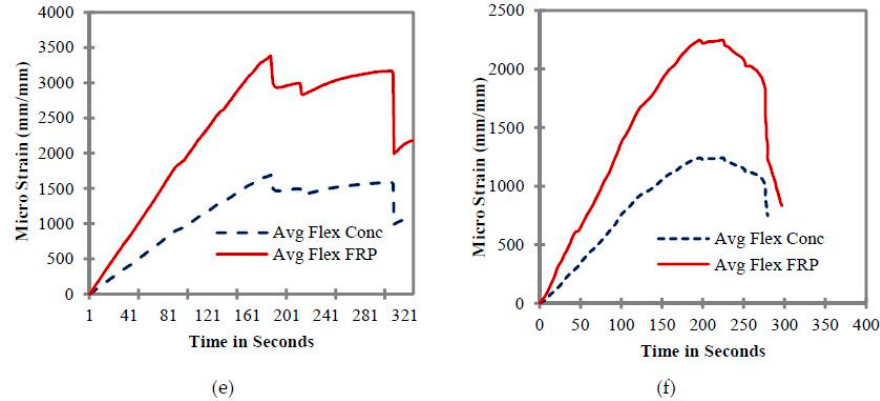
Figure 9. Comparison of concrete and CFRP flexural strain for ( a ) Control and B1, ( b ) Control and B2, ( c ) B3, ( d ) B4, ( e ) B5, and ( f ) B6.